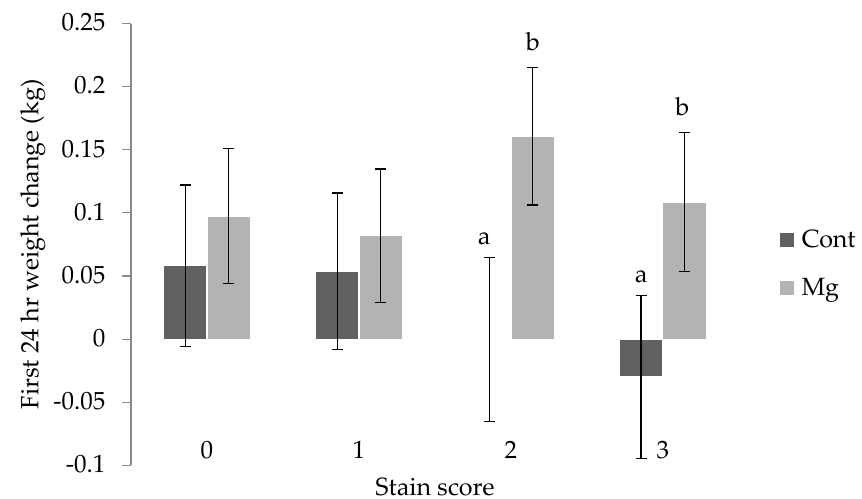
Figure 5. Mean ± s.e.m weight change (kg) over the first 24 h following birth for piglets with no staining receiving a score 0, some staining receiving a 1, moderate staining receiving a 2, and severe staining receiving a 3, from sows fed a standard lactation diet (Cont) and those supplemented with 21 g/day MgSO 4 (Mg) prior to farrowing. a,b Means within stain score not having the same superscript are significantly different ( p < 0.05).